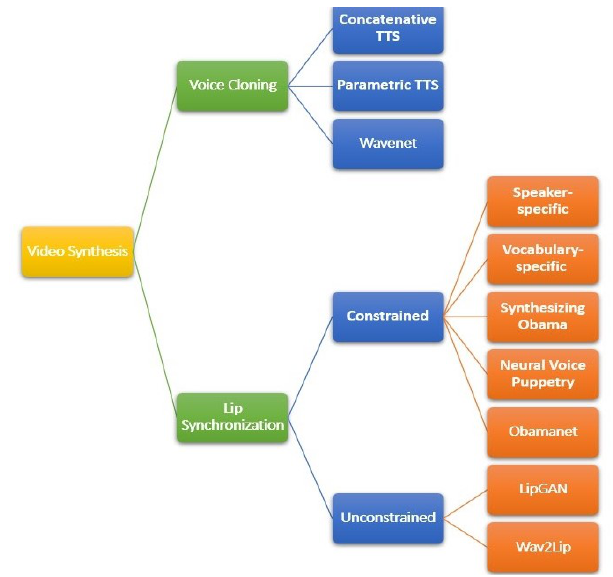
Figure 1. Different Techniques of Voice Cloning and Lip